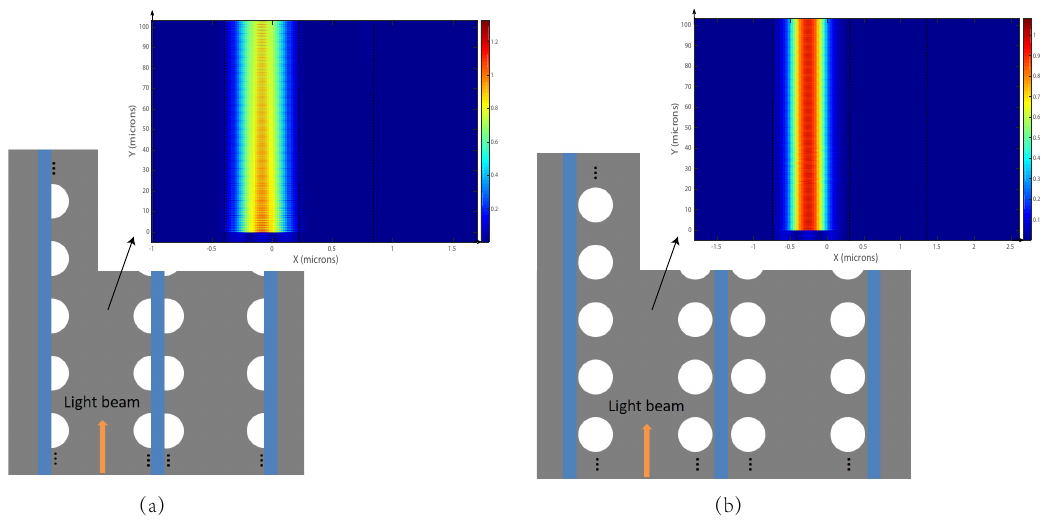
Figure 6. The structures of two closely spaced waveguides and their propagating fields: ( a ) the two waveguides with 0.5 column air holes; and ( b ) the two waveguides with 1 column. Lengths of waveguides are 100 µ m at the wavelength of 1.55 µ m. The dotted lines represent the boundaries between metal and